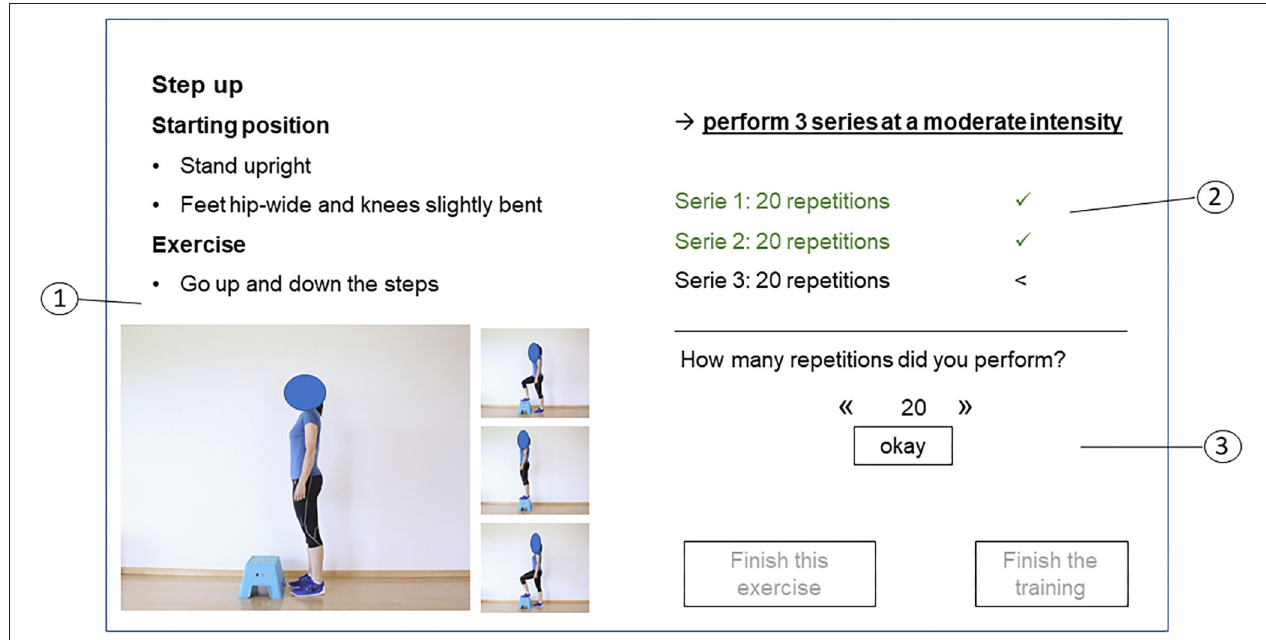
FIGURE 2 | Screen with exercise description of “play.” 1: Exercise overview presenting the exercise description (1), the target training parameters (series, repetitions and intensity) (2) and the possibility to indicate performed training parameters and to finish the exercise or the training (3).